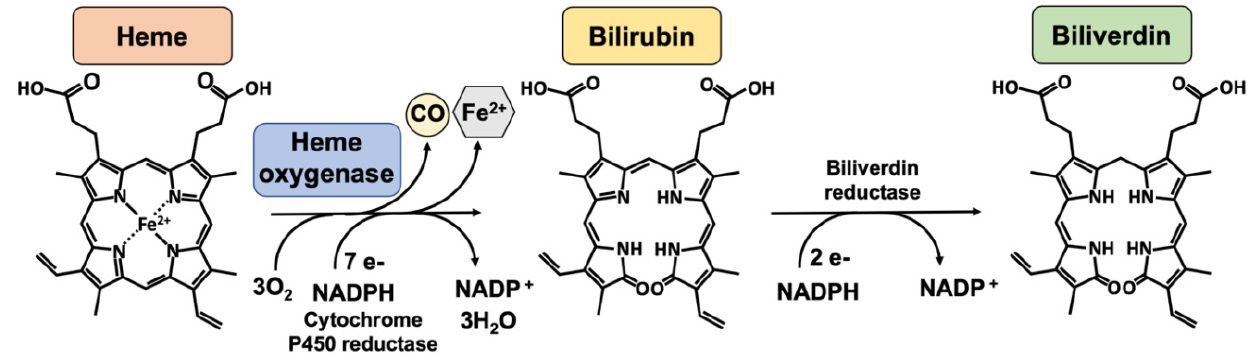
Figure 1. The heme oxygenase enzymatic reaction. Heme oxygenases degrade heme to sequentially generate carbon monoxide (CO), ferrous iron (Fe 2+ ), and biliverdin. The reaction requires 3 mol of molecular oxygen and 7 electrons from NADPH-cytochrome P450 reductase. Bilirubin is subsequently reduced to bilirubin by an NADPH-dependent biliverdin reductase. Legend: NADPH, nicotinamide adenine dinucleotide phosphate.